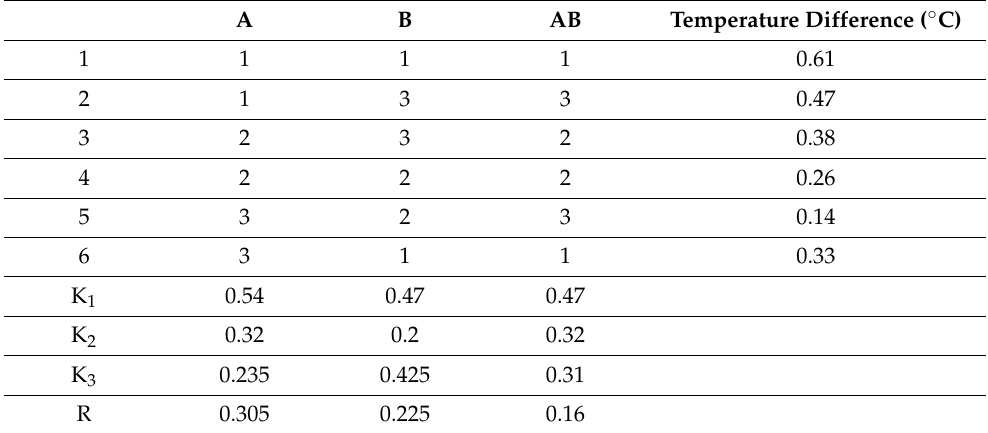
Table 7. The orthogonal testing results of thermal characteristics of surface under swell conditions. A